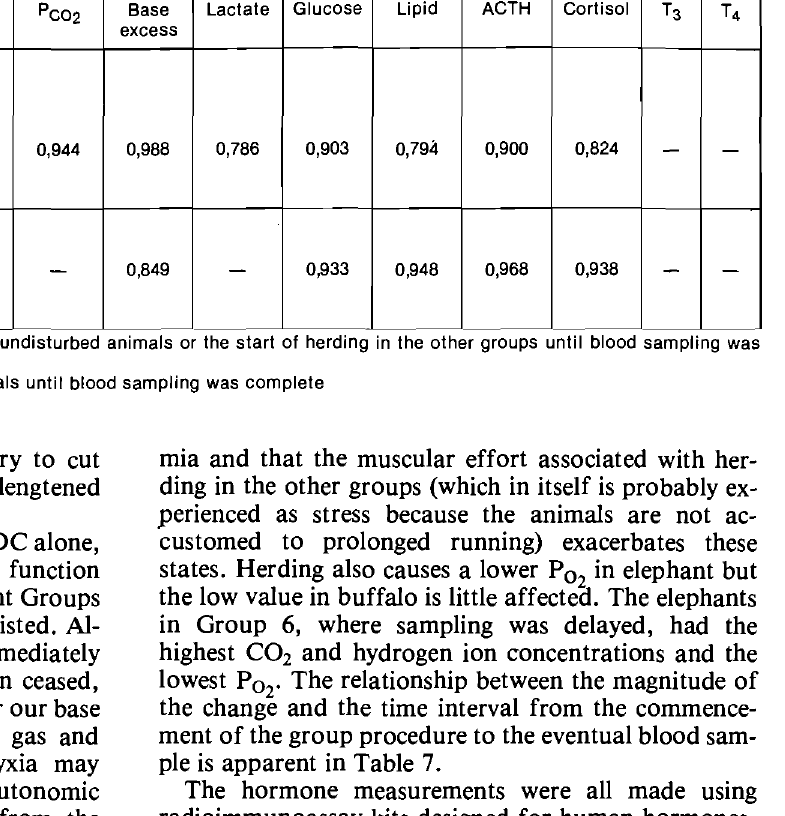
Table 7: THE RELATIONSHIP BETWEEN MEAN TOTAL TIMES AND THE MEANS OF DIFFERENT BLOOD VARIABLES EXPRESSED AS STATISTICALLY SIGNIFICANT CORRELATION COEFFICIENTS (P<O,01). Groups Mean Total Mean SDC pH P02 PC02 Base lactate Glucose lipid ACTH Cortisol T3 T4 Time' min Time" min excess Elephant